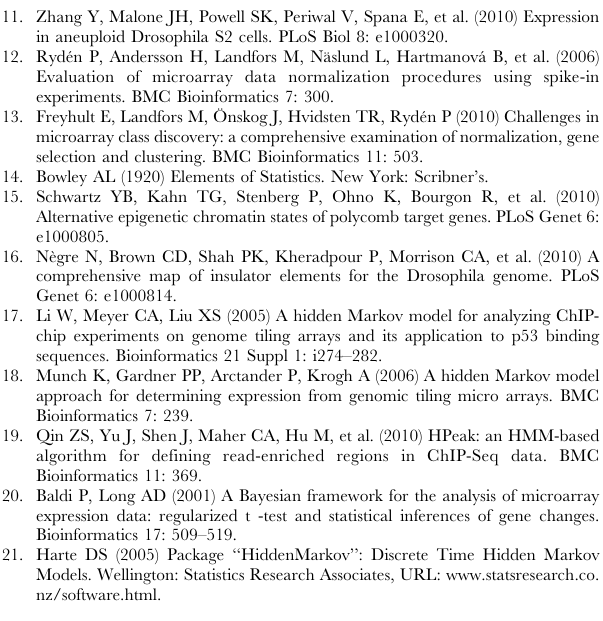
Table S5 The relative specificity of the HMM, invariant and standard quantile normalizations. Comparison of the specificity of the HMM, invariant and standard quantile normalizations relative to the performance of the ideal quantile observed specificity and the specificity observed using the